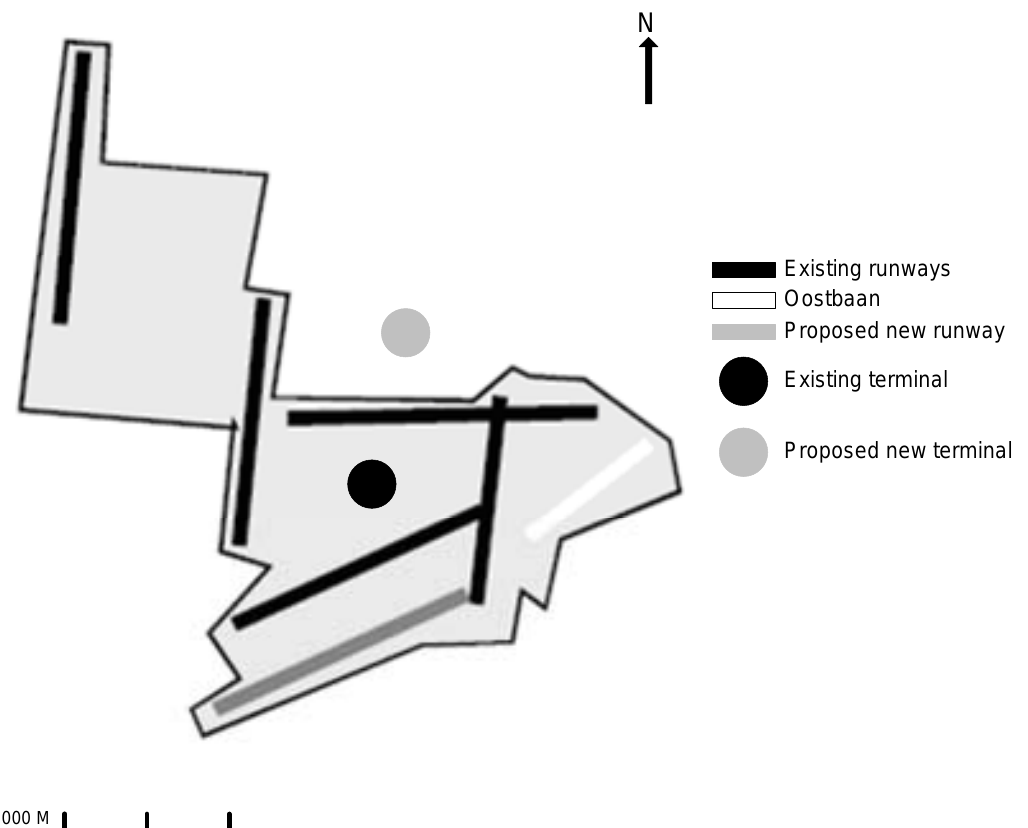
Figure 2. The planned extensions to Amsterdam Airport Schipho